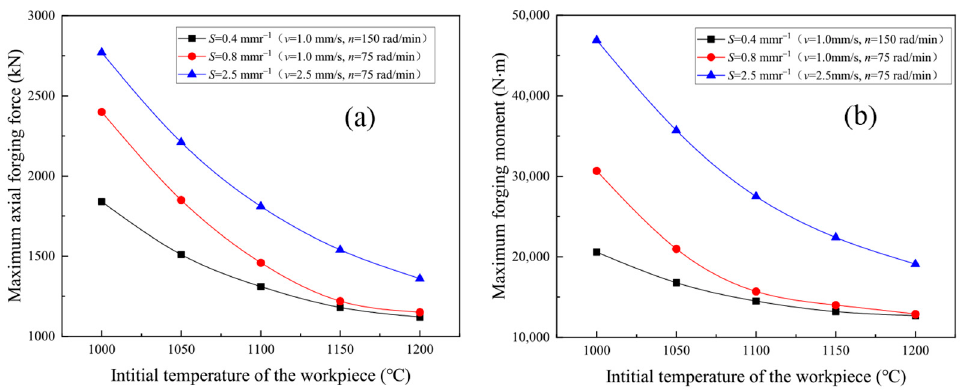
Figure 12. Interactive influence of feed amount per revolution S and initial temperature T of the disk workpiece on the maximum axial forging force and forging moment: ( a ) Interactive influence of feed amount per revolution S and initial temperature T of the disk workpiece on the maximum axial forging force; ( b ) Interactive influence of feed amount per revolution S and initial temperature T of the disk workpiece on the maximum forging moment.